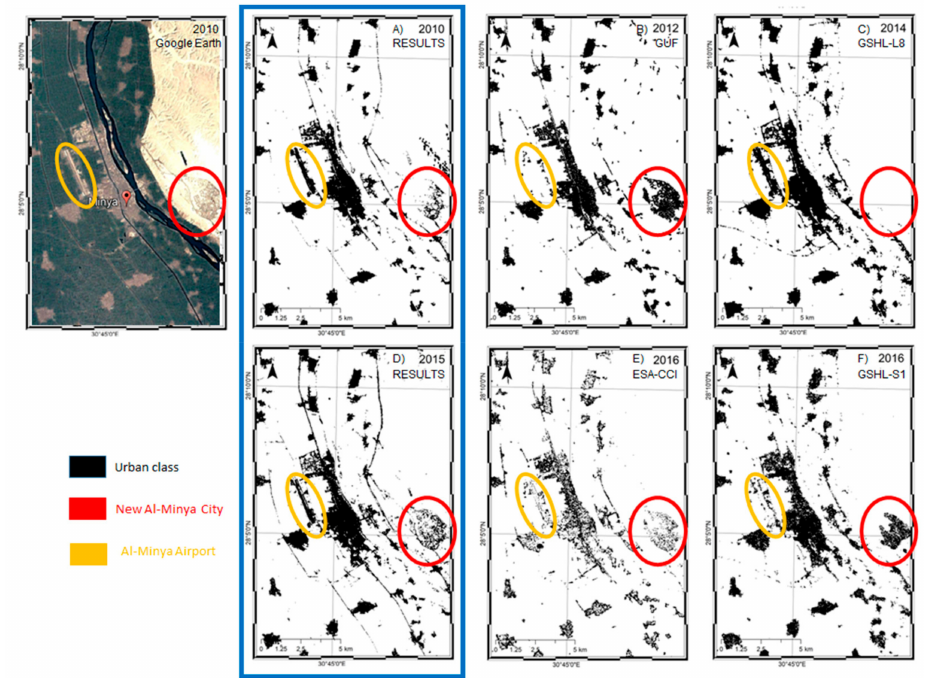
Figure 9. Urban / built-up area of El-Minya city and surroundings from the di ff erent datasets: ( A ) 2010, this study, ( B ) GUF for 2012, ( C ) GHSL-L8 2014, ( D ) 2015, this study, ( E ) ESA-CCI Prototype 2016 and ( F ) GHSL-S1 2016. In colour circles, di ff erent areas highlighting di ff erent classification performances. The blue rectangle highlights our